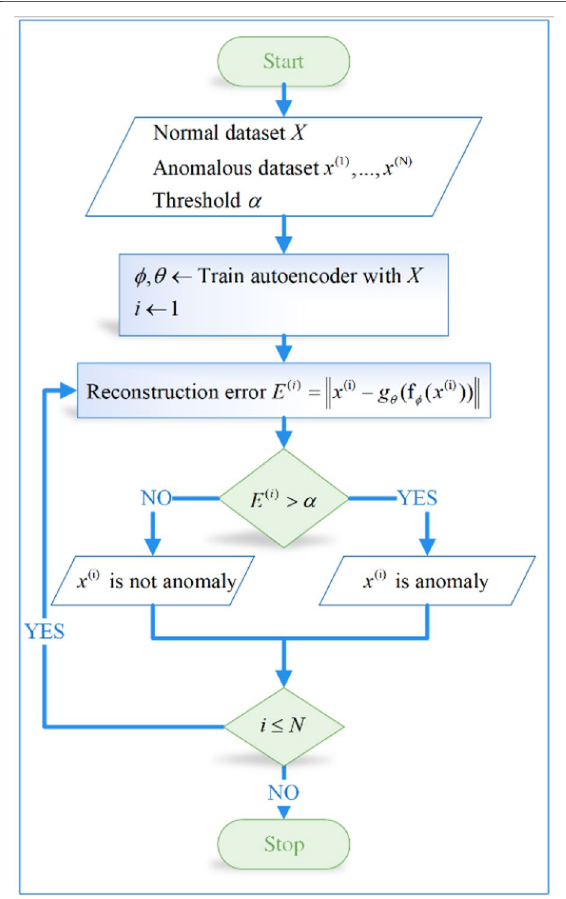
Fig. 3 The flow chart of autoencoder based anomaly detection